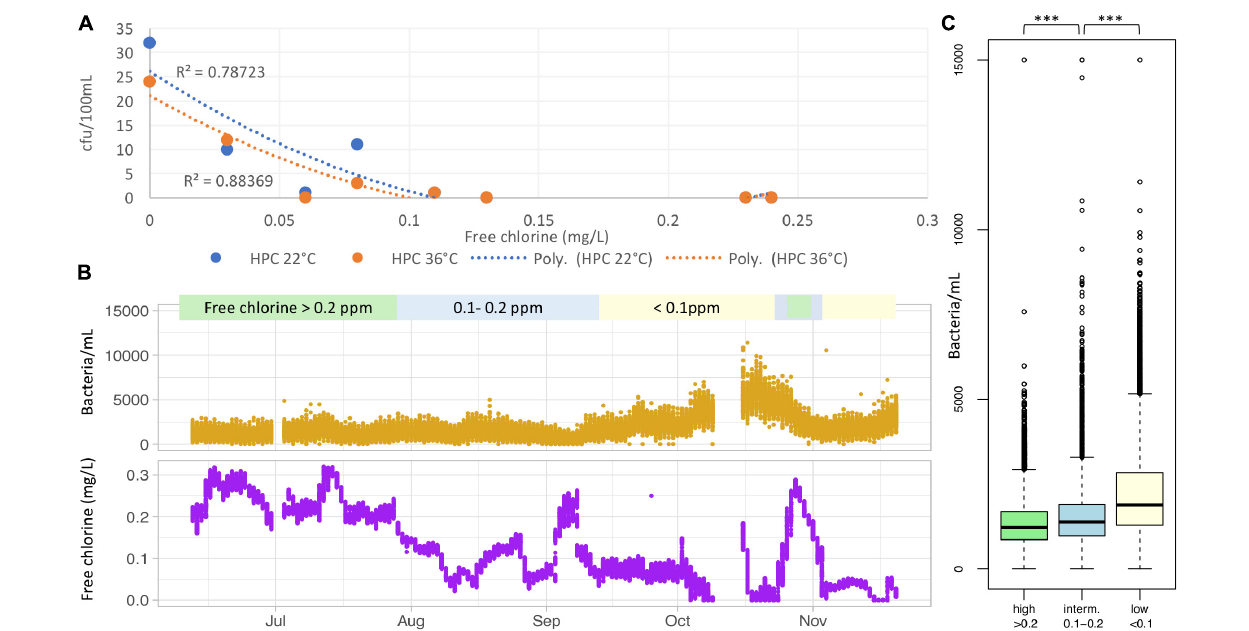
FIGURE 2 | Water quality measures. (A) Chlorine concentration is negatively correlated with heterotrophic plate counts (HPC, CFU/100 mL) at different temperatures when considering all samples from both cities. However, HPC remains lower than commonly accepted values at all chlorine concentrations. (B) The BACMON online sensor shows the variation in bacteria/ml at the drinking water tank outlet of City#1 (Sample C) following the decrease of chlorine over a 5-month period at the same location. The blank periods in early July and mid-October were due to an accidental switch-off of both on-line sensors. Each sensor generated more than 20.000 measurements. (C) Bacterial counts by the BACMON differ significantly between the three categories of chlorine concentration, even without taking into consideration the latency in bacterial